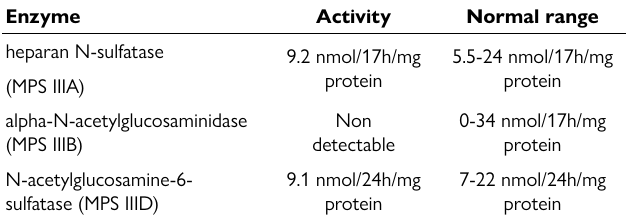
Table 2. Evaluation of the activity of selected enzymes. Enzyme Activity Normal range heparan